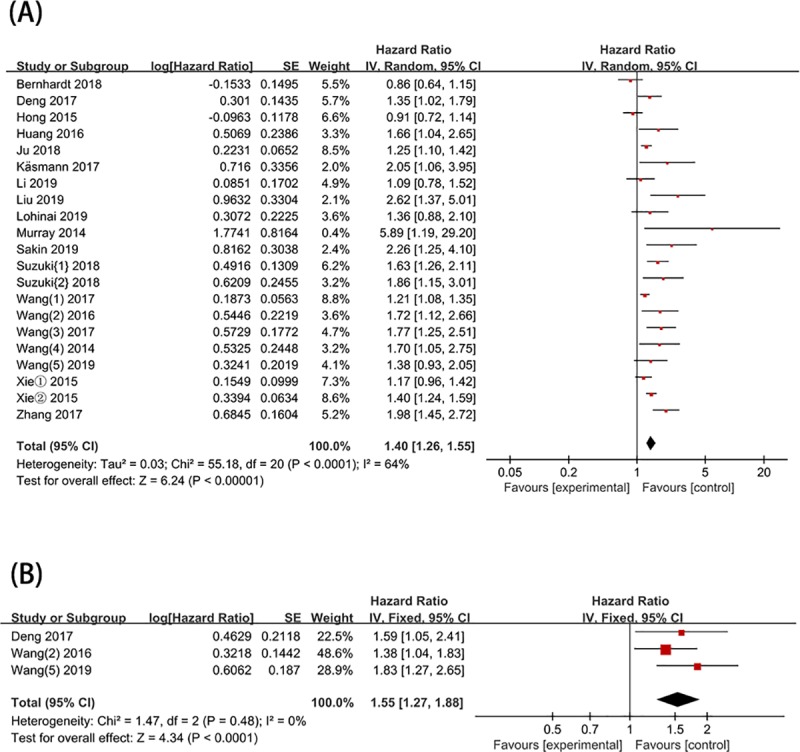
Forest plot of HR for the association of pretreatment NLR in patients with SCLC.(A) OS; (B) PFS.